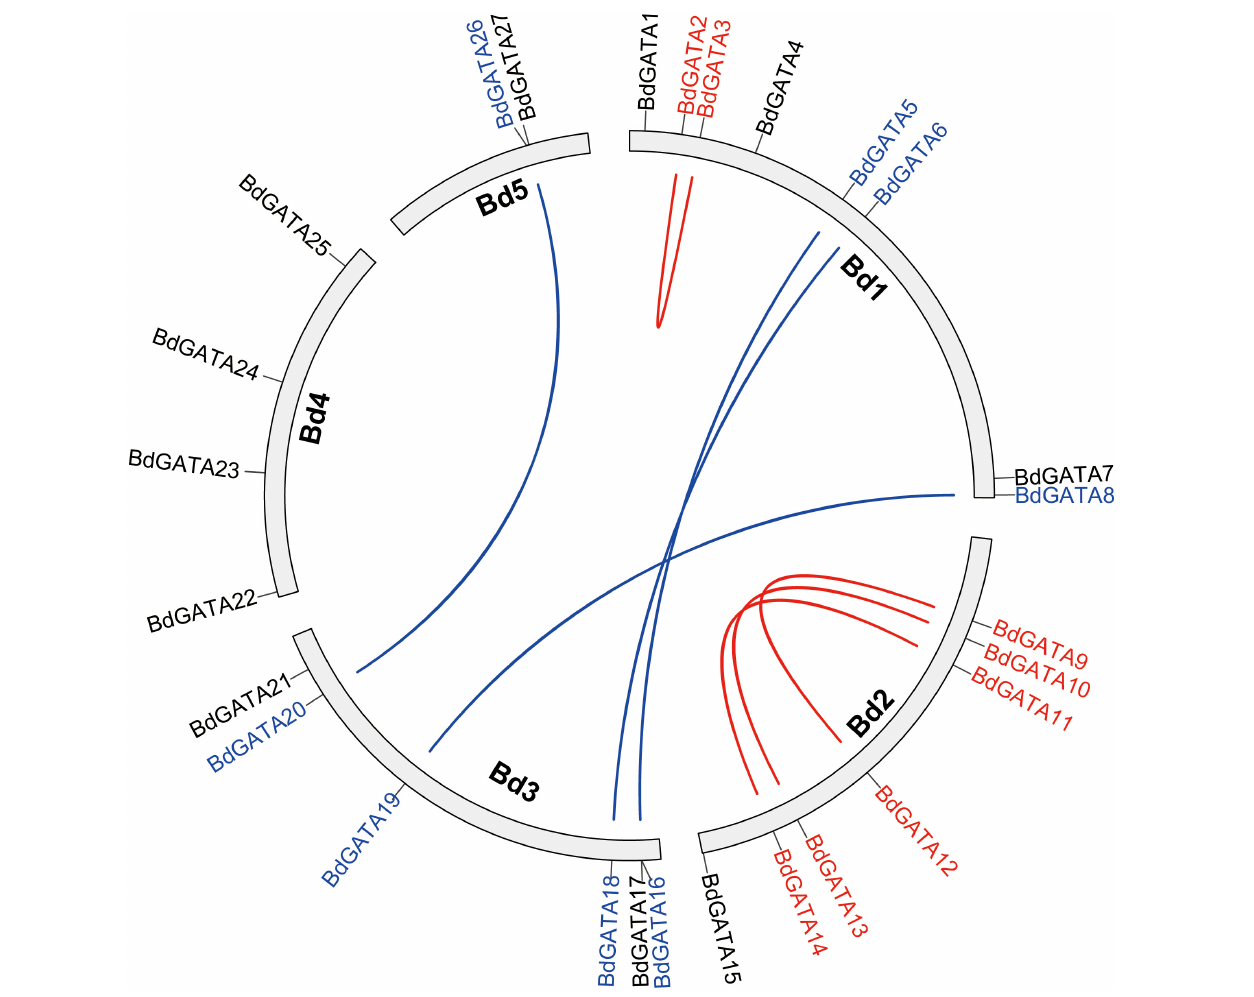
FIGURE 1 | Chromosome locati on and analysis of duplicated BdGATAs . Red lines connect tandemly duplicated genes; blue lines connect segmentally duplicated